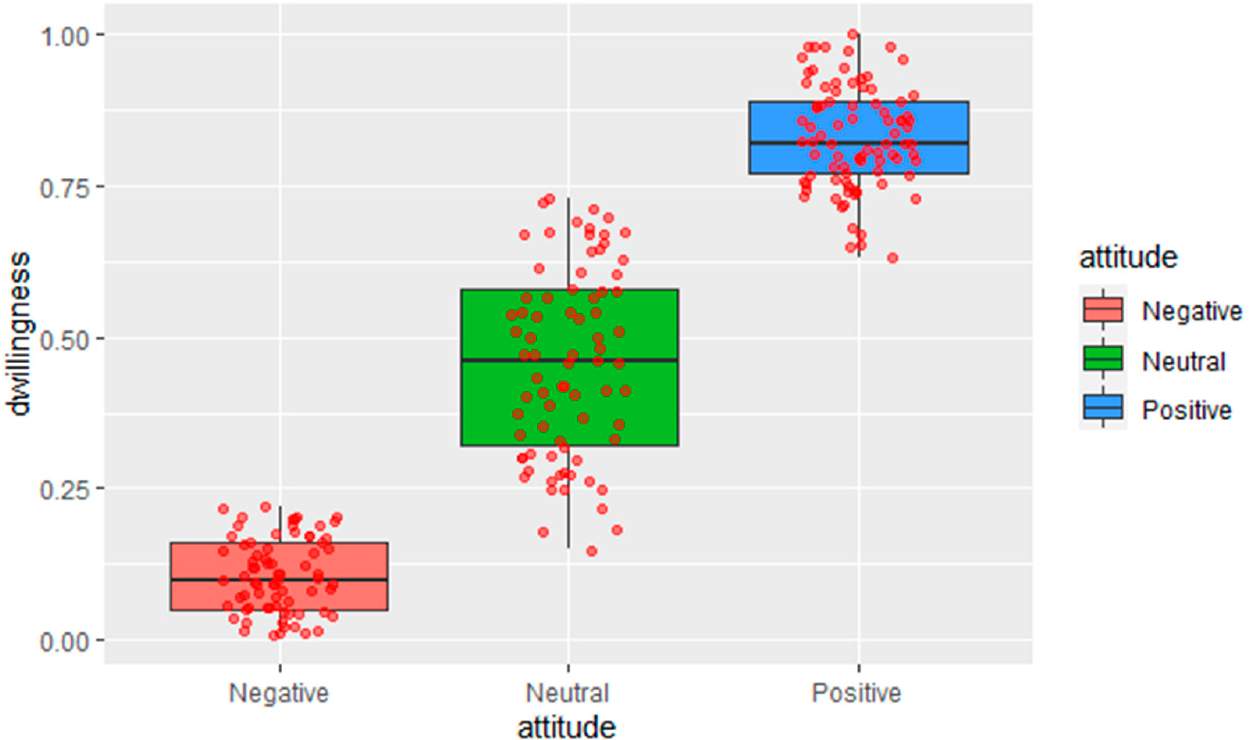
Figure 7. Land requisition willingness of different types of farmers.